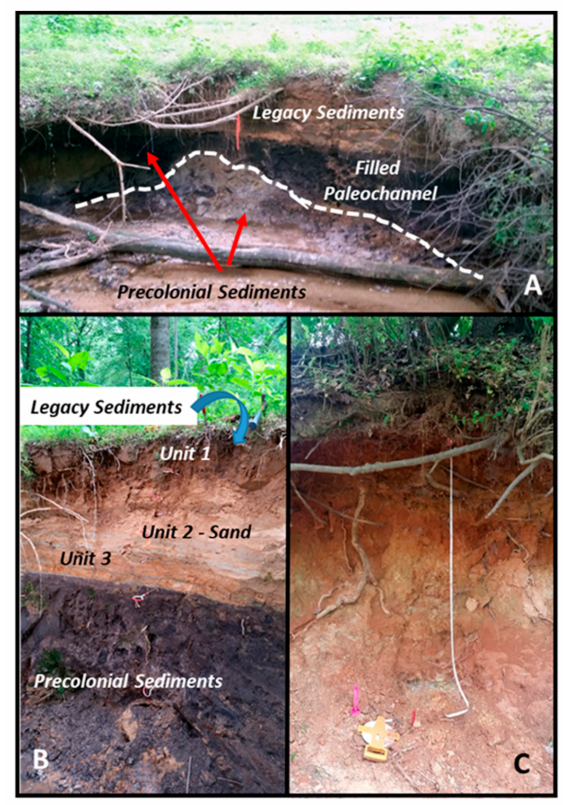
Figure 2. Bank exposure located along an entrenched alluvial channel ( A ) near the confluence of Stick Elliot and Fletcher Creek, and ( B ) upstream, along Stick Elliot Creek. Reddish brown to buff- colored sediments in photos A and B represent stratified legacy deposits that locally contain loose, sand-sized sediments. Dark, organic-rich sediments are interpreted as cohesive, erosionally resistant precolonial deposits; ( C ) highly weathered alluvial sediments and soil that underlie upland areas (hillslopes) near the confluence of Stick Elliott and Fletcher Creeks. See Figure 1 and Figure 5 for stream channel